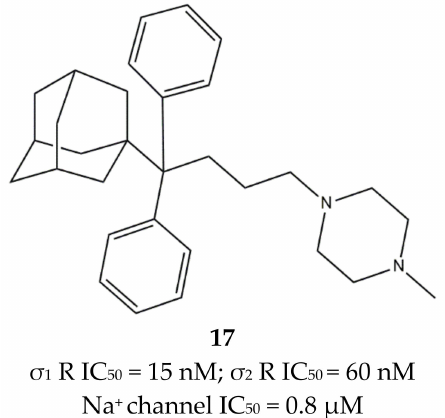
Figure 14. Compound ( 17 ) structure and its IC 50 values for σ 1 receptor ( σ 1 R), σ 2 receptor ( σ 2 R) and Na + channel